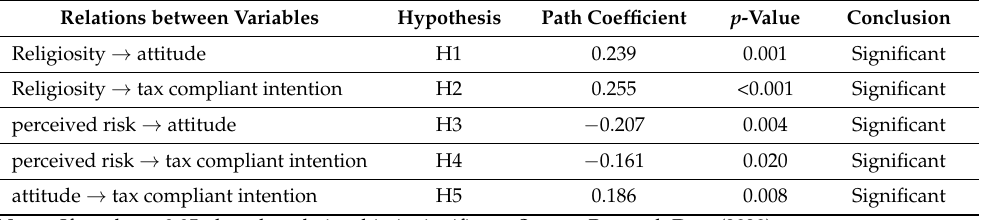
Table 4. Result of estimation and testing the direct effect. Relations between Variables